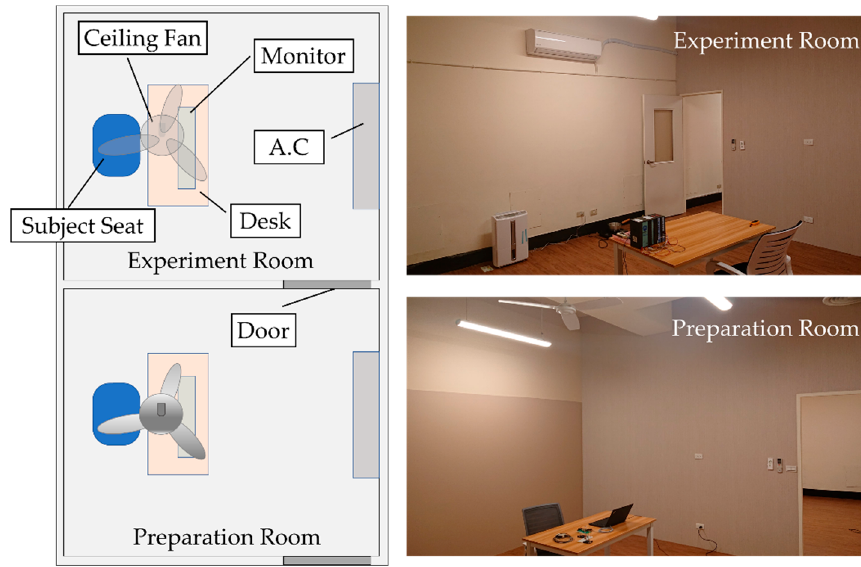
Figure 1. Experimental rooms.